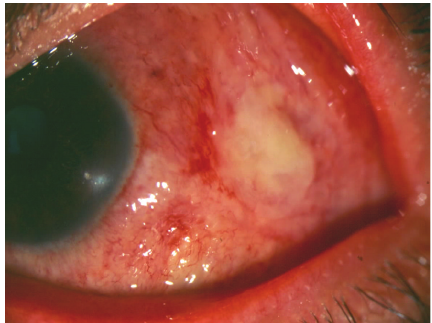
Figure 14: Hyphae and inflammatory cells observed in aqueous humor from case in Figure 14 × 1000.